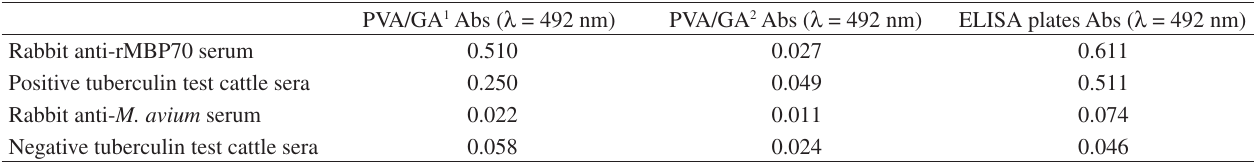
Table 1. Comparison of ELISA using hydrogel PVA/GA, commercial ELISA plates as support and rMPB70 as solid phases. PVA/GA 1 Abs ( λ = 492 nm) Rabbit anti-rMBP70